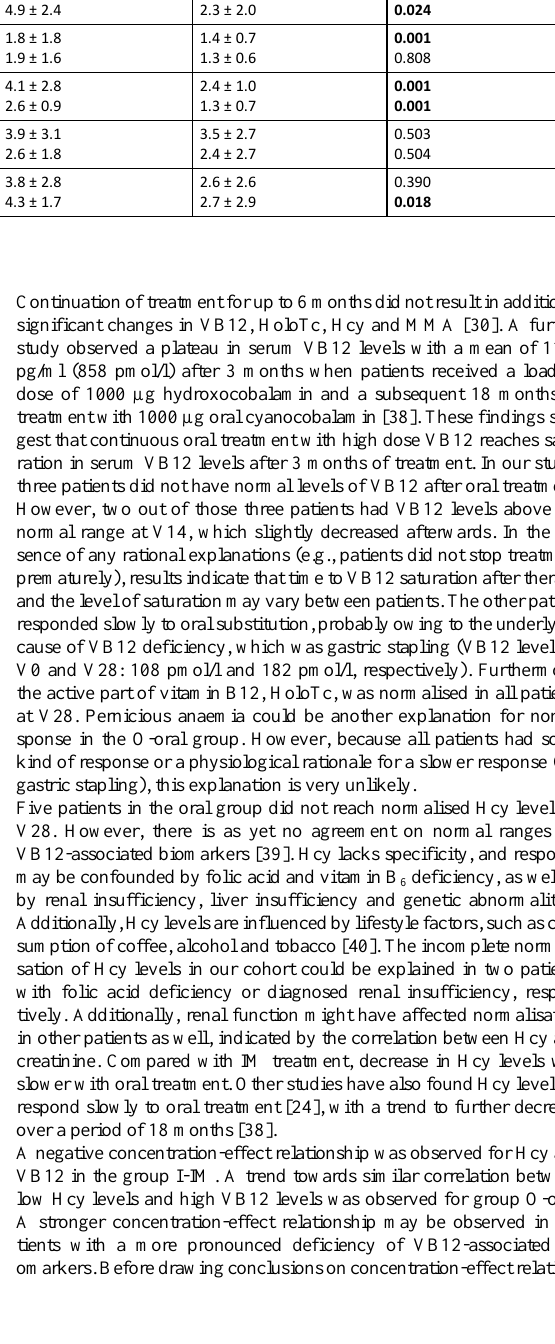
Item Prefers tablets (n =